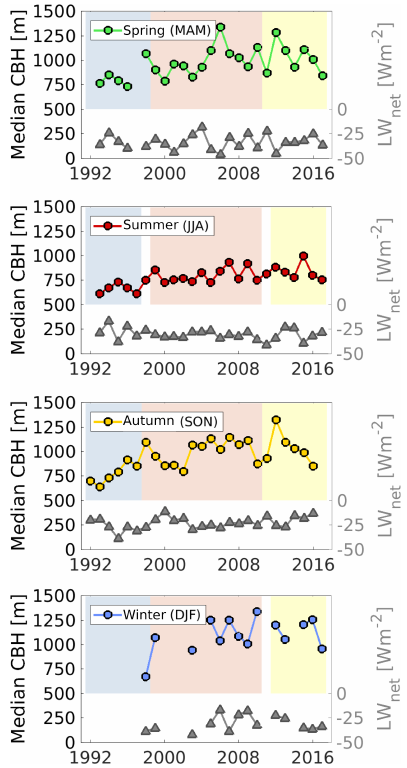
Figure 5. Median cloud base height (dots; left axis) for spring months March–April–May, summer months June–July–August, au- tumn months September–October–November, and winter months December–January–February, shown from the uppermost to low- ermost panels, respectively. Only data with > 20% available cloud detection data during the season are considered, leading to gaps, especially in winter. The background shading indicates the differ- ent instrumentation (light blue – LD-WHX, light red – LD-40, light yellow – CL-51). Additionally, the median long-wave net radiation LW down − LW up from simultaneous BSRN surface radiation mea- surements is shown for the same cloudy periods (triangles; right axis),